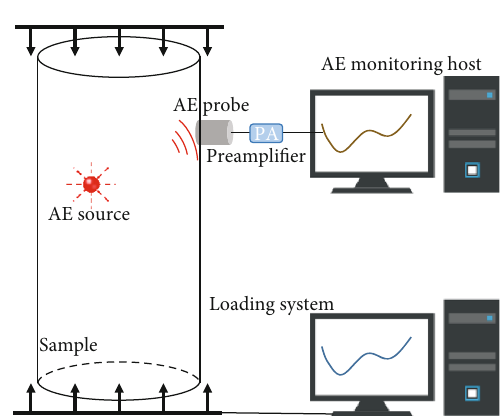
Figure 3: Experimental system